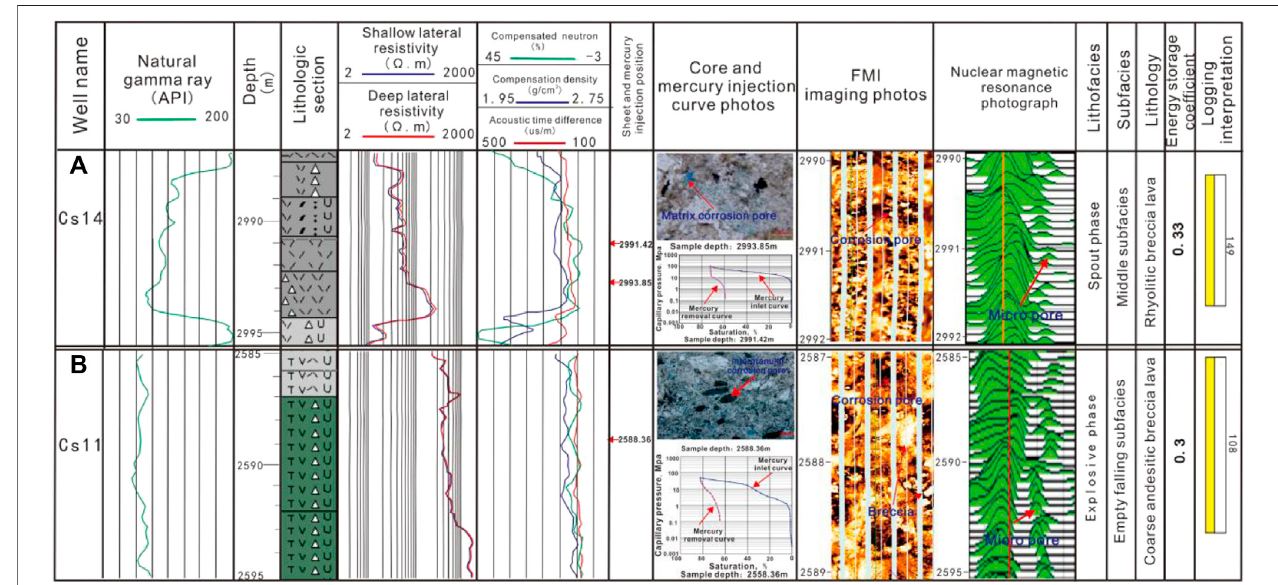
FIGURE 10 | Typical logging evaluation map for Type II volcano reservoir in the Wangfu Gas Field. Notes: (A) Well Cs14; (B) Well Cs11.